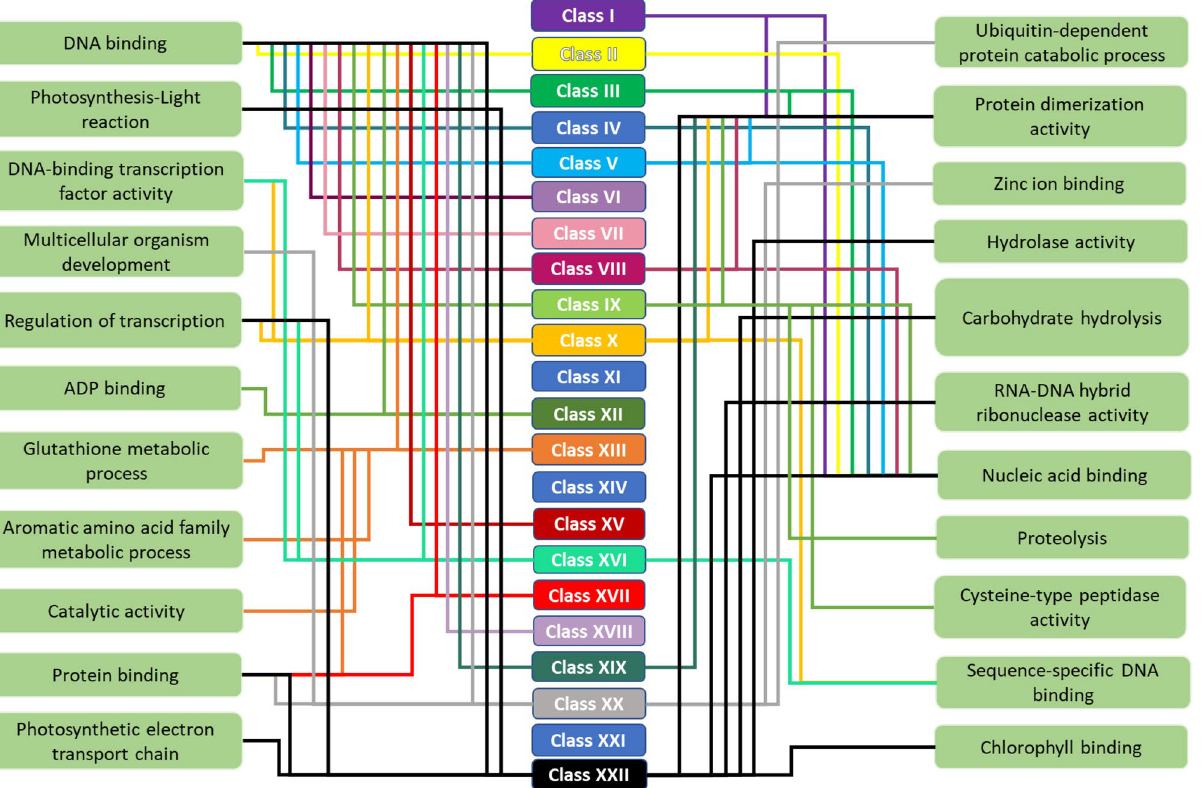
Figure 4. Zf-BEDs classes with their gene ontology-predicted molecular